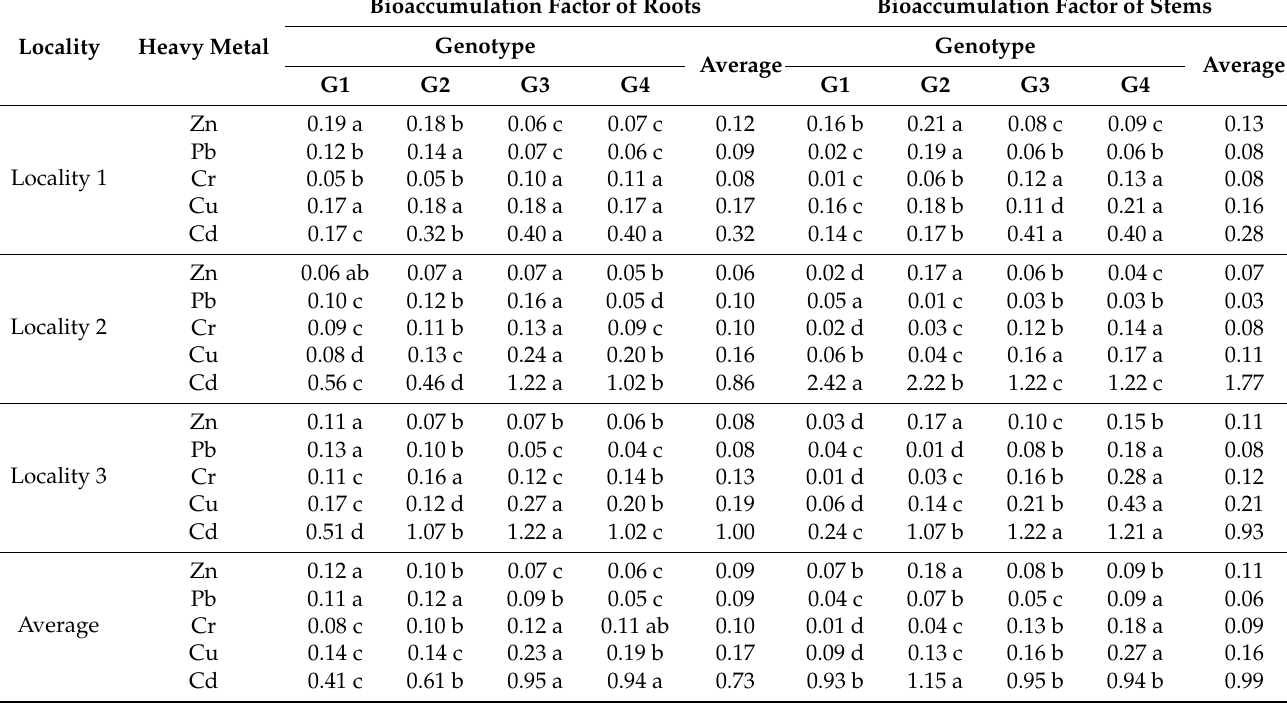
Table 4. The bioaccumulation factor of roots and stems of analyzed wheat genotypes grown at different